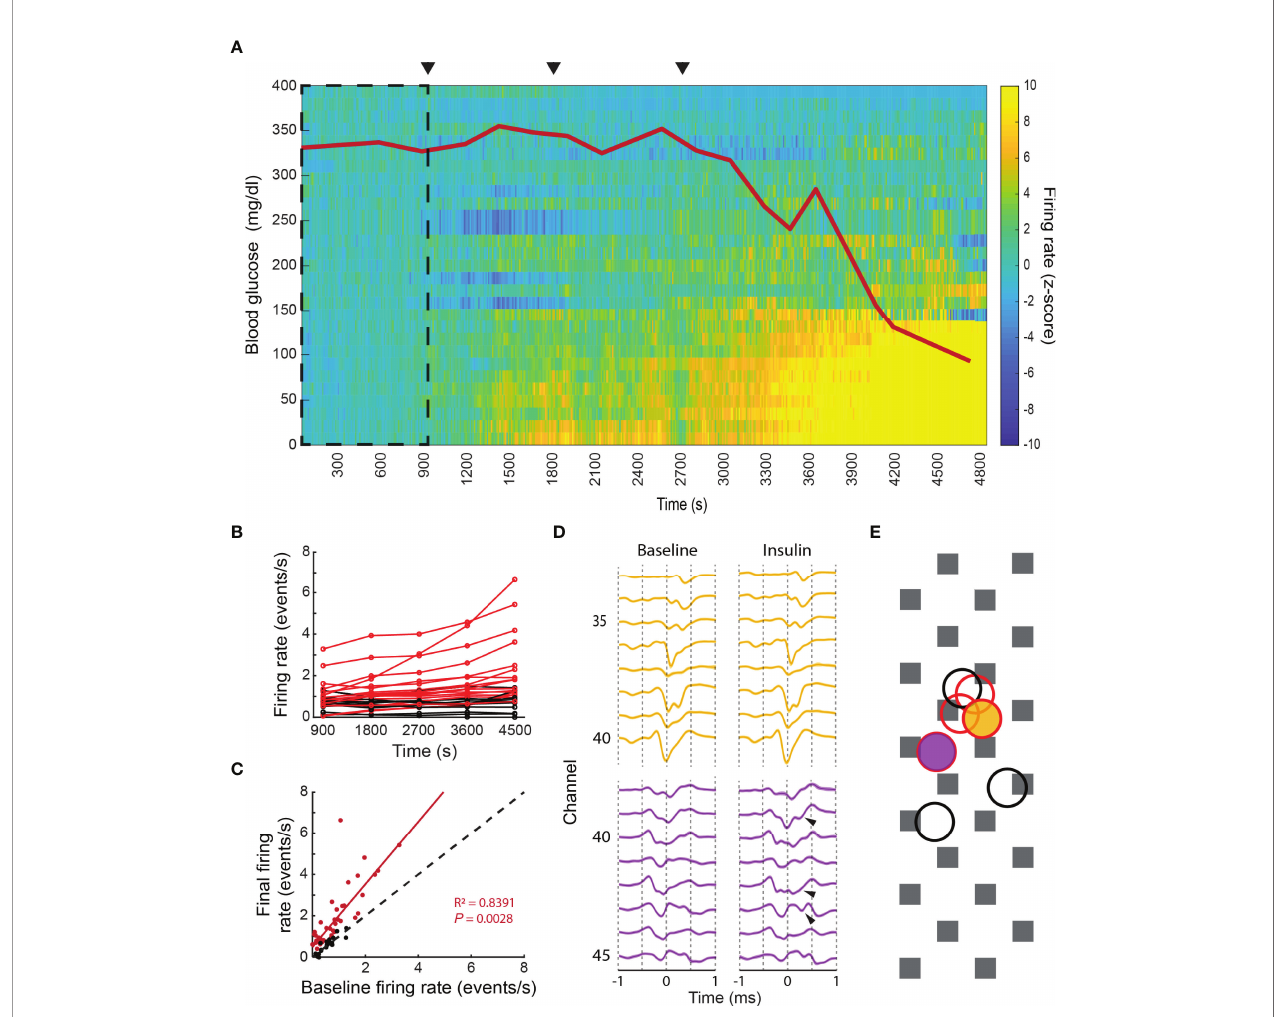
FIGURE 6 | Physiological stress response in the intact adrenal medulla. (A) The intraperitoneal administration of 3 increasing doses of insulin, 10, 100 and 1000 µg/ kg (arrowheads), induced a decrease in the blood glucose levels (red line) that correlated with a signi fi cant increase in the fi ring frequency of a subpopulation of chromaf fi n cells. The z-score was calculated per unit in 10s bins by taking the fi rst 900s as baseline (dashed square). The experiment was divided into fi ve 15 minutes periods: baseline (1-900s), 10 µg/kg (901-1800s), 100 µg/kg (1801-2700s), 1000 µg/kg (2701-3600s) and fi nal (3601-4500s) (B) Individual averaged fi ring rate for the different periods (red indicates units whose fi nal averaged fi ring rate increased by more than 2 times its baseline ’ s SD or averaged z-score above 2, black indicates the units that presented no change between its baseline fi ring rate and fi nal fi ring rate or an averaged z-score between ±2). (C) Linear regression between the baseline fi ring rate vs. fi nal fi ring rate for 64 units recorded from 3 preparations. The coef fi cients for the linear fi tting are 1.523 (1.265, 1.78 with 95% con fi dence bounds), the 45-degree dashed line represent no change between the two evaluated periods. (D) Waveform changes during hypoglycemia. Top template (yellow) displayed no changes between the baseline and the 1000 µg/kg periods, whilst additional spikes (arrows) were found in the bottom unit in comparison to its baseline template, both units presented a statistically signi fi cant increase in their fi ring rate between the two periods. (E) Firing rate change does not correlate with the spatial localization of the cells. The yellow and purple fi lled circles indicate the localization of the units shown in (D) , which had increased fi ring rates upon hypoglycemia. The red and black un fi lled circles represent the localization of additional units. Red circles represent cells whose fi ring rate increased; black circles represent cells whose fi ring rate